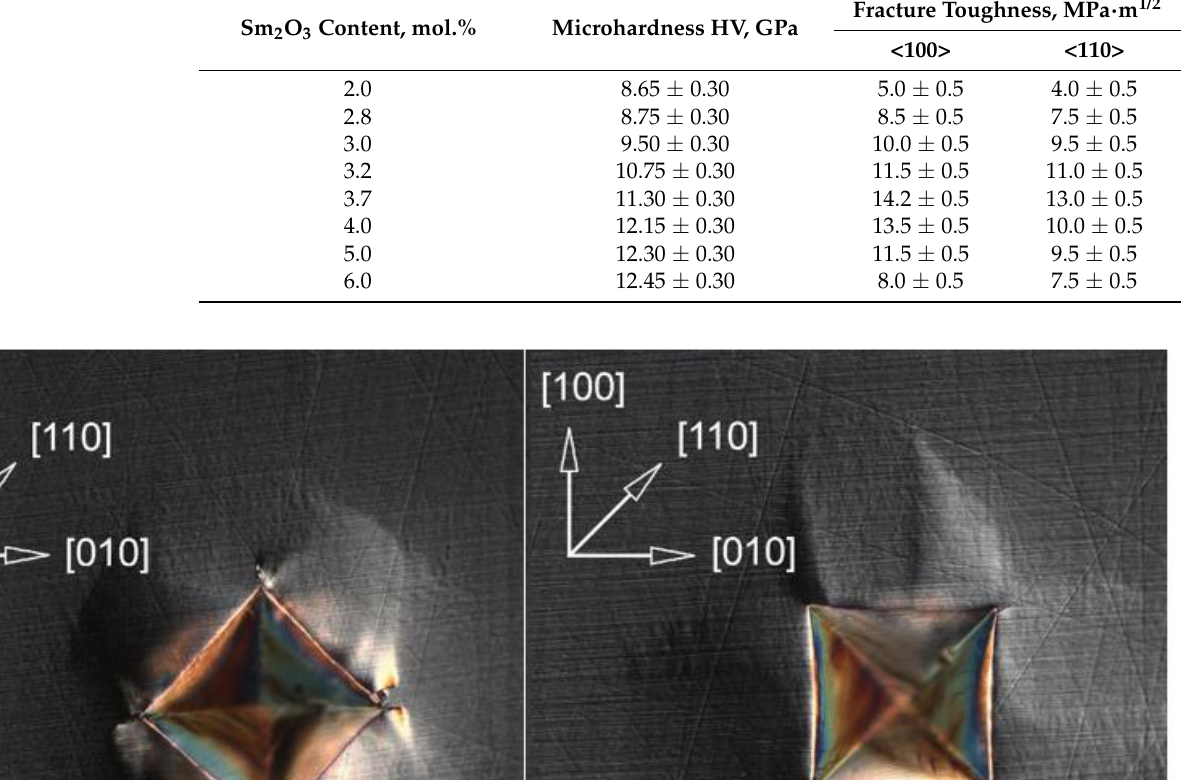
Table 2. Microhardness and fracture toughness of (ZrO 2 ) 1-x (Sm 2 O 3 ) x crystals.